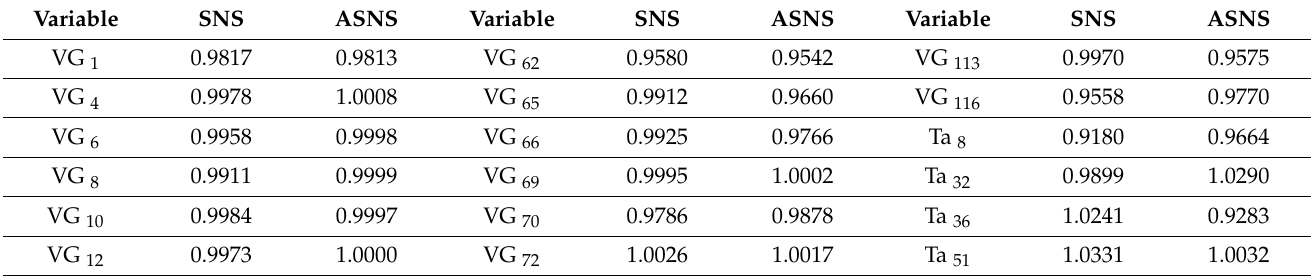
Table 11. Optimal results for Case 2 of the IEEE 118-bus grid.